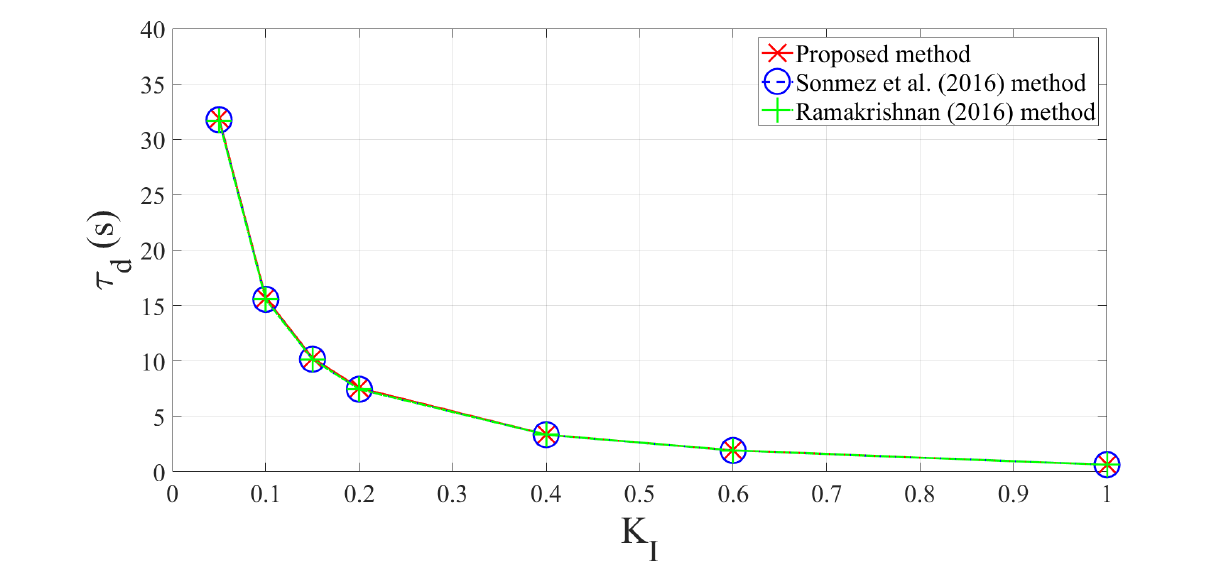
Figure 4. With K P = 0.05, the DM, τ d , is shown against the integral gain, K I , curve